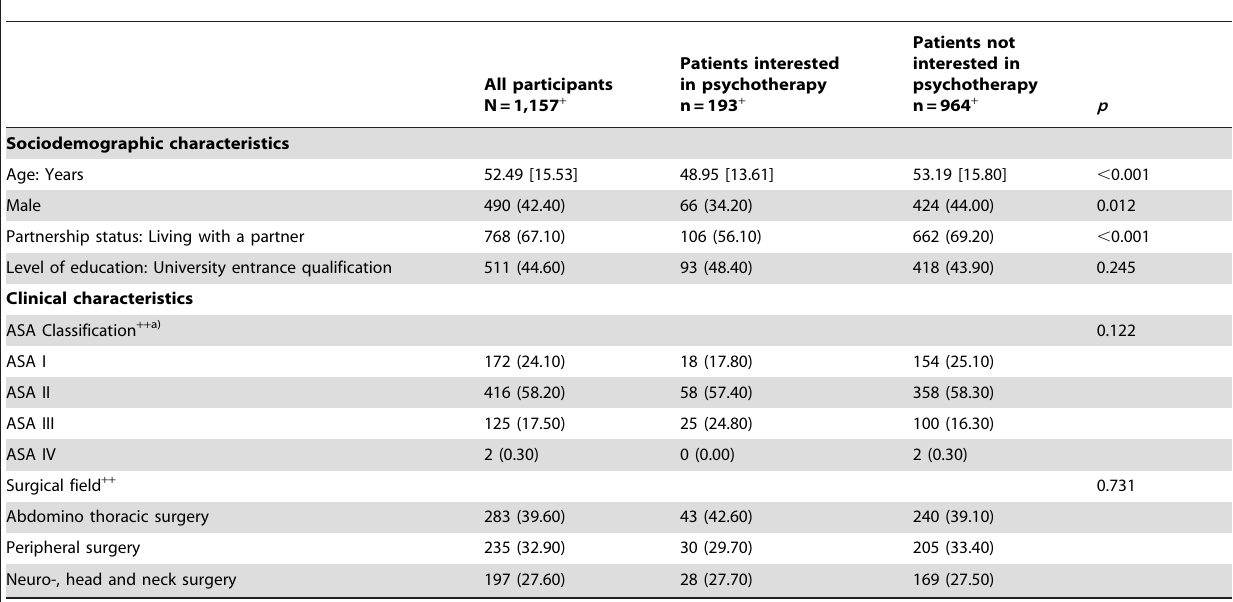
Table 3. Sociodemographic and clinical characteristics of all participants of the 6-month follow-up (N= 1,157), as well as comparison of patients who showed interest in psychotherapy (n=193) and patients who were not interested in psychotherapy (n=964); mean [SD], n